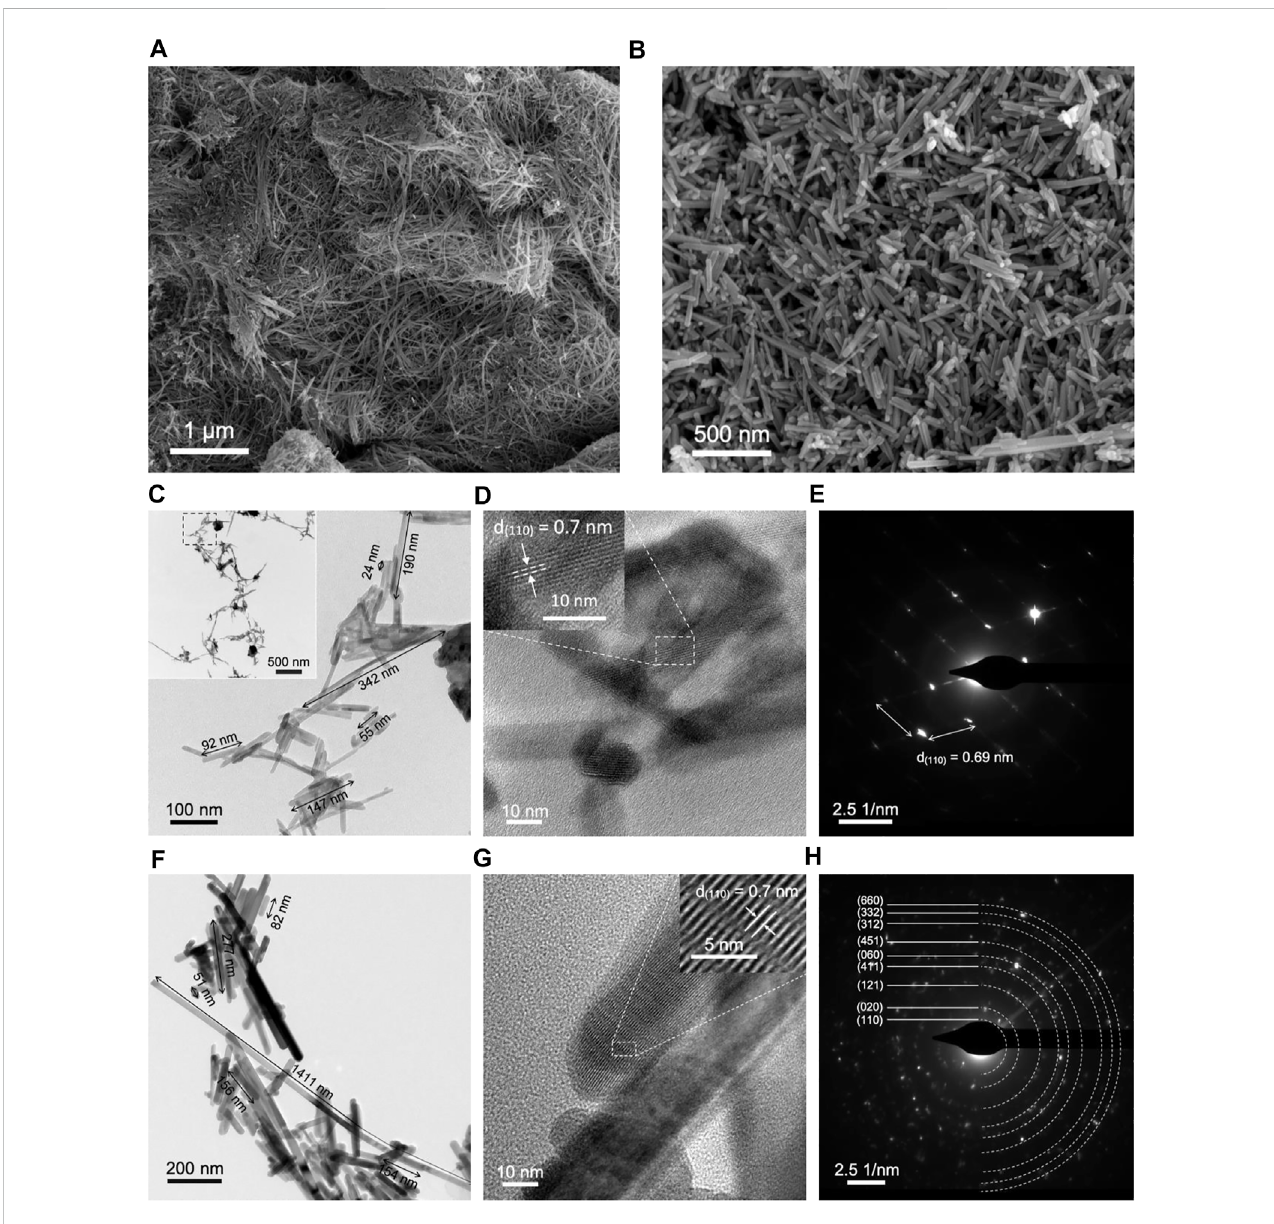
FIGURE 2 SEM images of (A) MnO 2 nano fi bers and (B) Ce-MnO 2 nanorods. TEM, HRTEM and SAED pattern images of (C – E) MnO 2 and (F – H) Ce-MnO 2